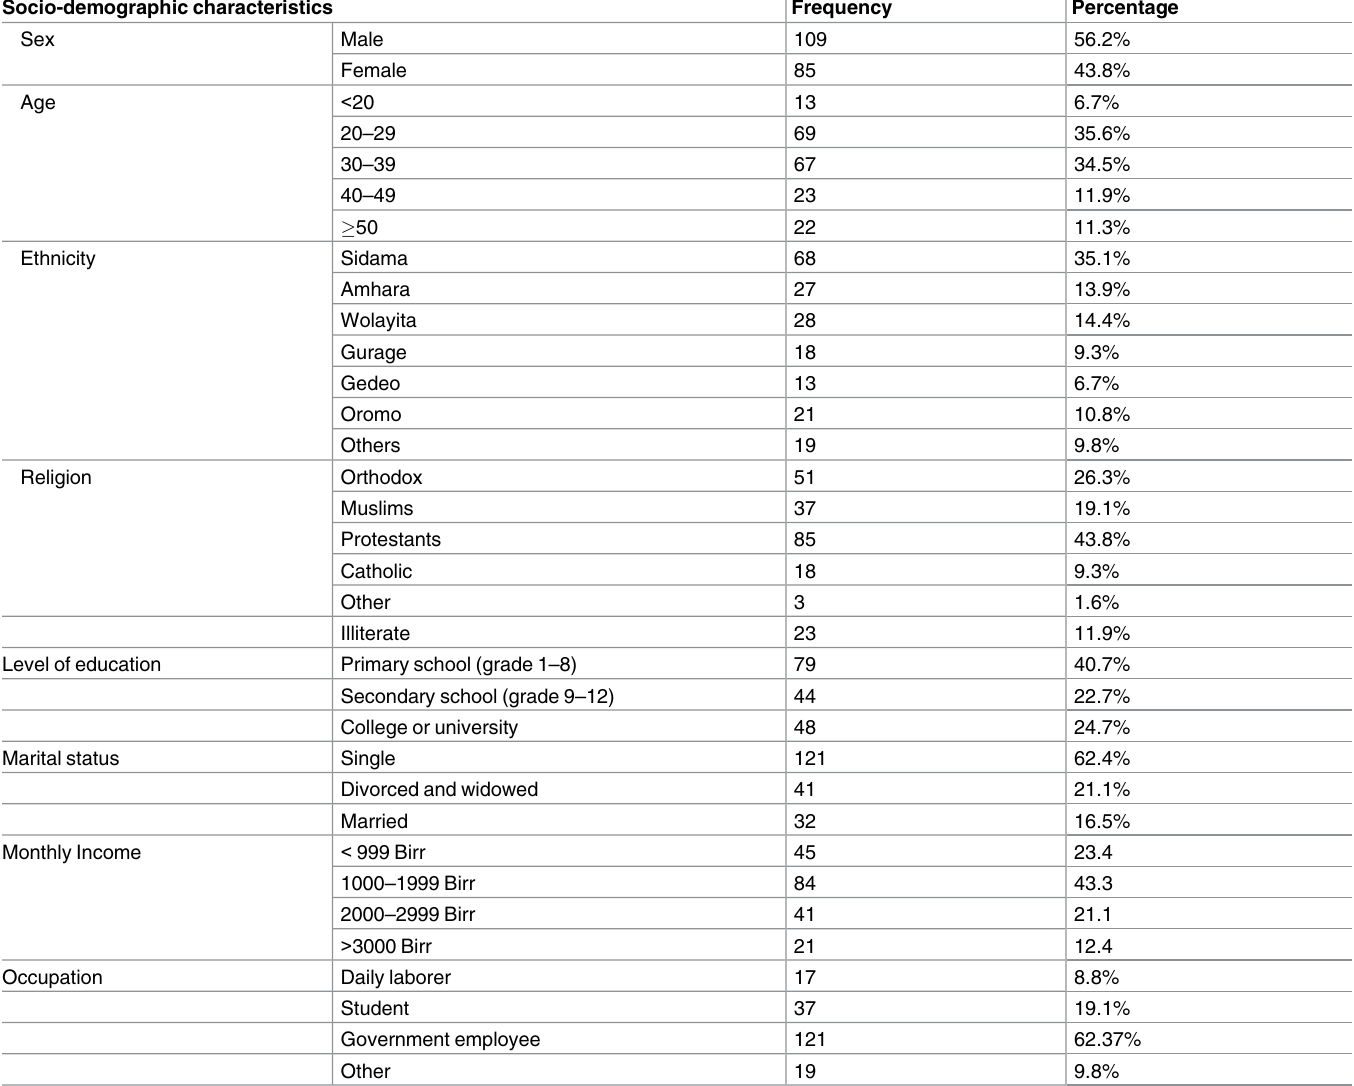
Table 1. Sociodemographic characteristics of epileptic patients at Yirgalem General